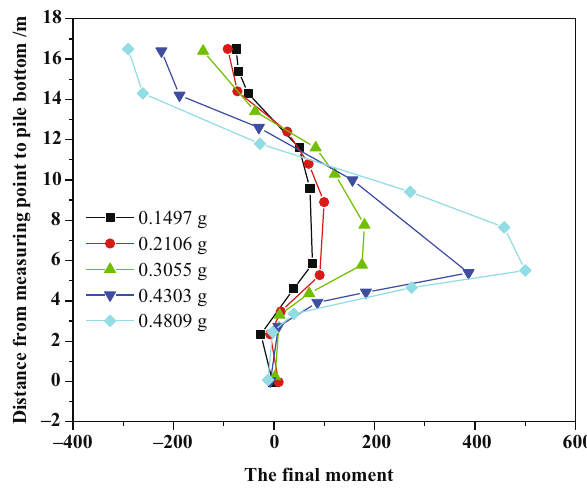
Figure 5: Final bending moment of P2